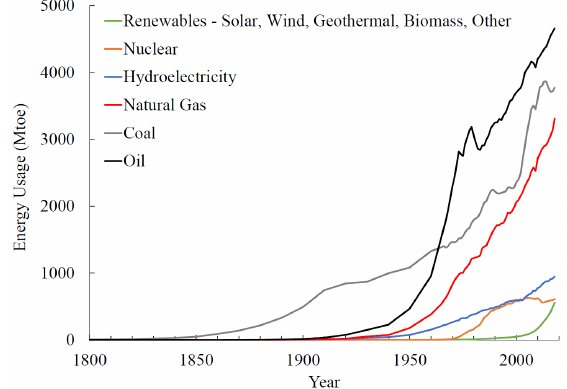
Figure 8. World energy usage by energy source, from 1800 to 2018, given in units of million tonnes of oil equivalent (Mtoe). Traditional biomass (e.g., wood) has not been included in this figure. Renewables include solar, wind, geothermal, biomass and waste. Data are from BP (Statistical Review of World Energy, 1965 ‐ 2018) [30] and Our World in Data (Energy Production and Changing Energy Sources, 1800 ‐ 1960) [31]. Data from Our World in Data were converted from units of terawatt ‐ hours to Mtoe using the following conversion factors: 0.086 for coal, oil and natural gas, and 0.226 for hydroelectricity.